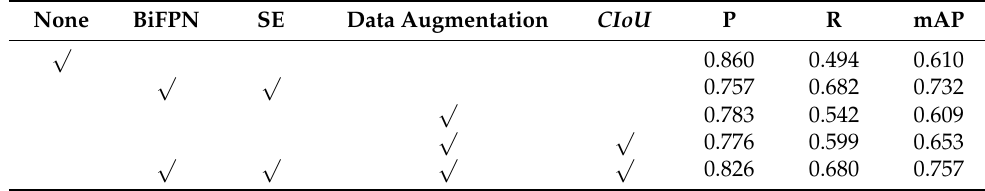
Table 2. Performance comparison before and after using different